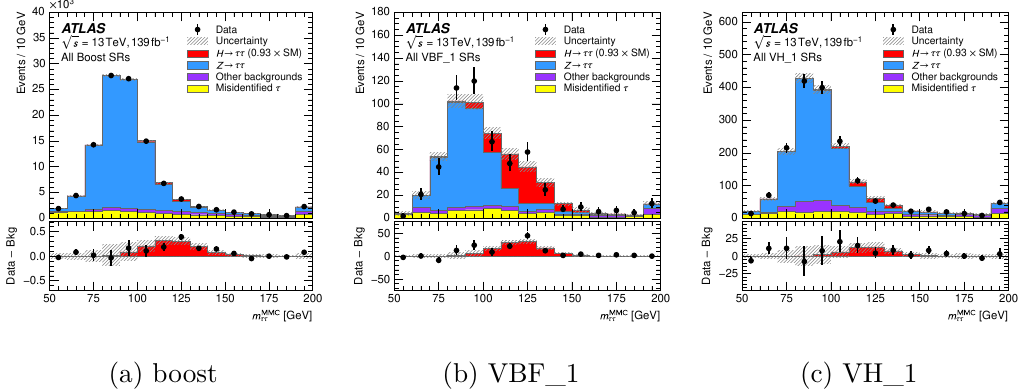
Figure 9. Distribution of the reconstructed ττ invariant mass ( m MMC ) for all events in the (a) ττ boost, (b) VBF_1 and (c) VH_1 signal regions. The bottom panel shows the differences between the numbers of observed data events and expected background events (black points). The observed Higgs boson signal, corresponding to ( σ × B ) / ( σ × B ) = 0 . 93 , is shown with a filled red histogram. SM Entries with values above the x -axis range are shown in the last bin of each distributions. The dashed band indicates the total uncertainty on the total predicted yields. The prediction for each sample is determined from the likelihood fit performed to measure the pp → H → ττ cross-section.